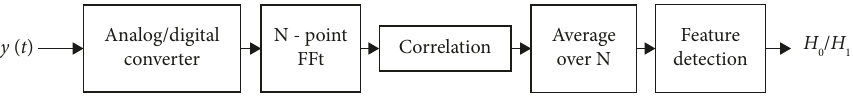
Figure 15: Block diagram of the cyclo-stationary analysis